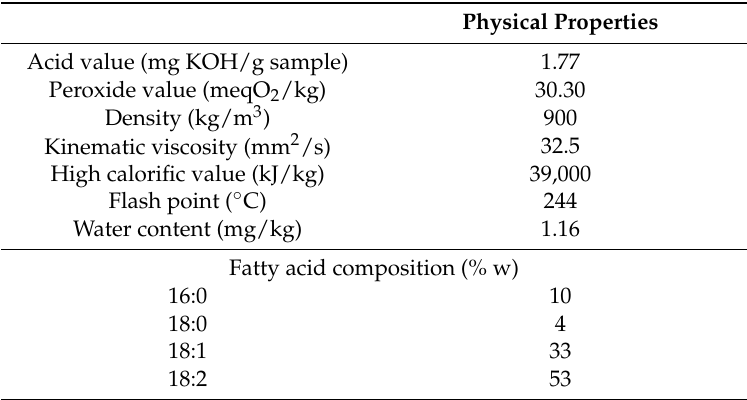
Table 1. Used frying oil